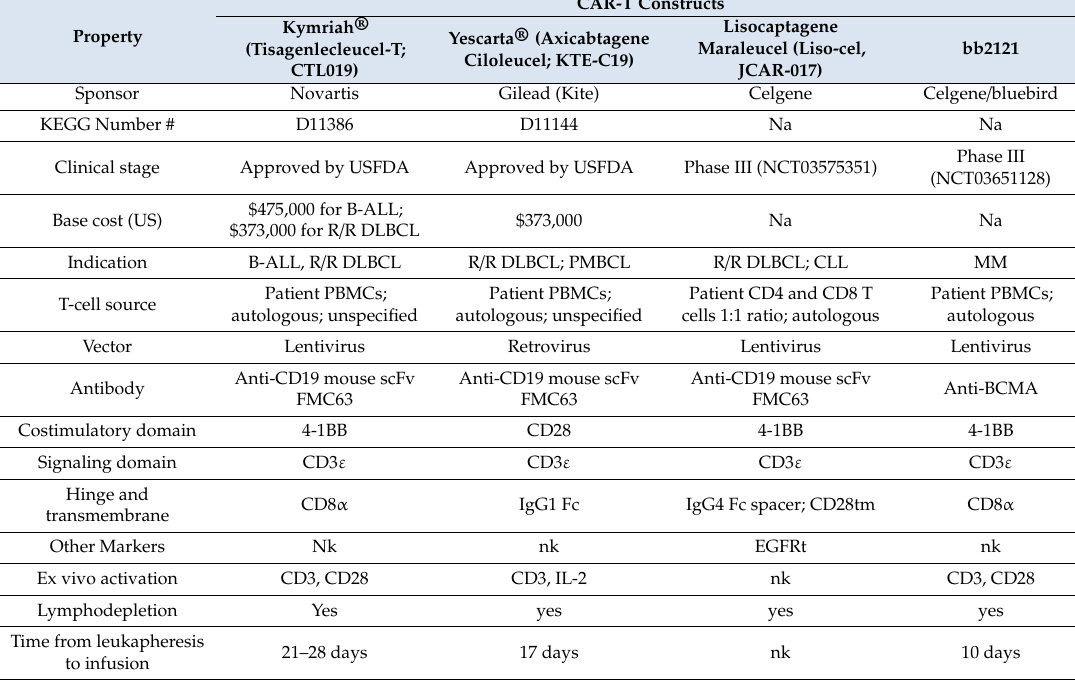
Table 4. Brief comparison of autologous CAR-T